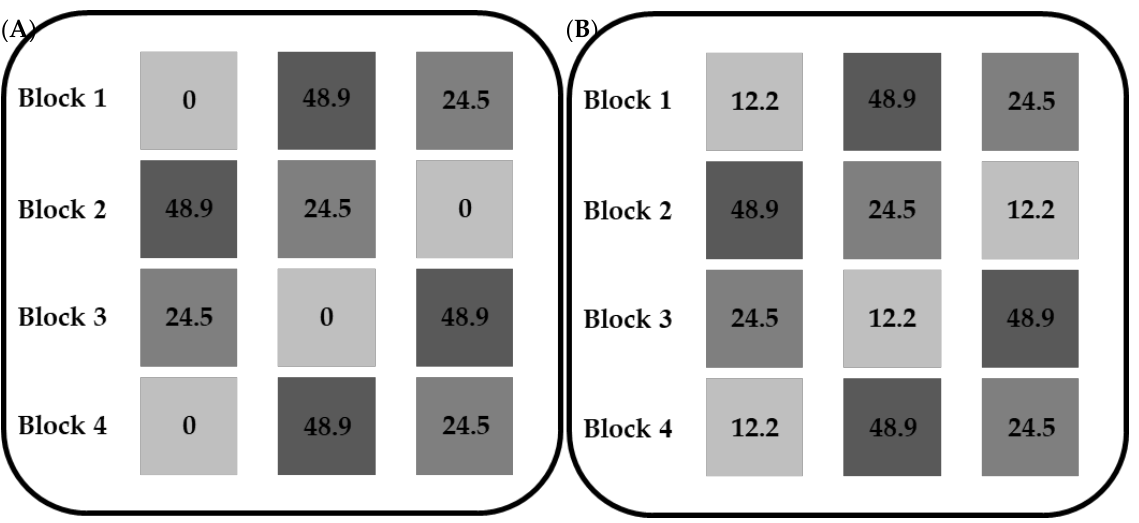
Figure 1. P trial layout on Farms ( A , B ) in 2018 ( A ) and in 2019 and 2020 ( B ). Numbers refer to fertilizer P rates (kg P ha −1 ). When the soil temperature is low at planting 12.2 kg P ha −1 is applied as starter fertilizer according to the UF/IFAS recommendation for P management for potato production (Table 4 at https://edis.ifas.ufl.edu/publication/CV002 (accessed on 24 March 2022)). The plot arrangements were all the same in each of the three years.